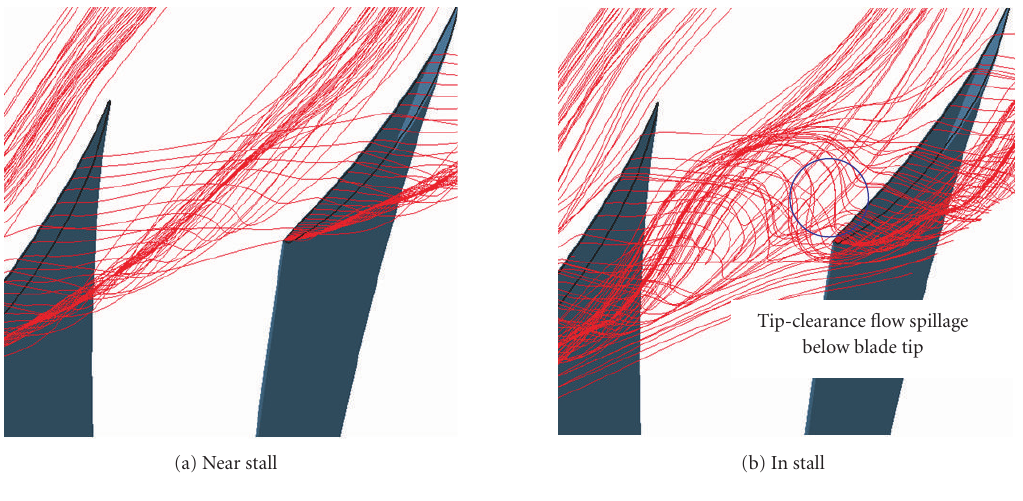
Figure 10: Comparison of particle traces.